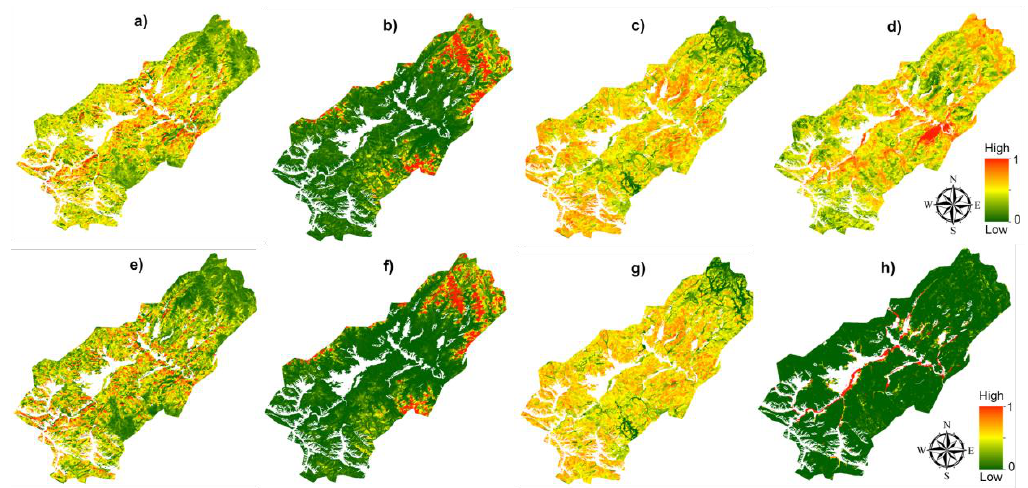
Figure 5. Tree species probability maps generated using Landsat imagery ( a ) birch, ( b ) cedar, ( c ) larch, ( d ) willow and Landsat imagery coupled with topographic variables ( e ) birch ( f ) cedar, ( g ) larch, and ( h ) willow.